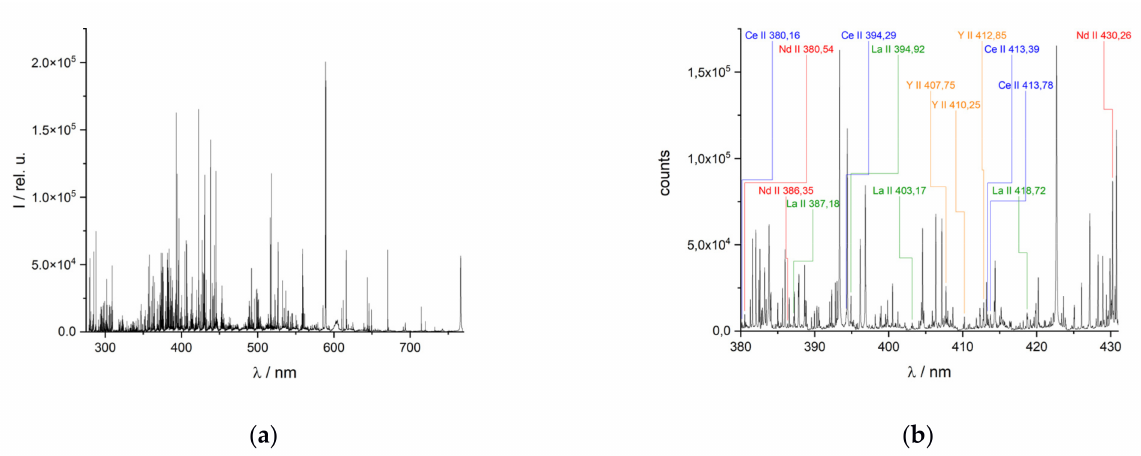
Figure 2. Representative LIB spectrum of a monazite-xenotime-apatite-bearing vein: ( a ) the entire spectrum ( λ = 275–750 nm) and ( b ) a partial spectrum ( λ = 380–430 nm) with important REE emission lines.